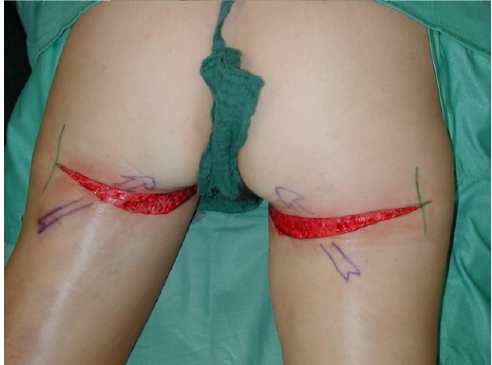
Figure 12. Deepithelialising of the scar for refixation.